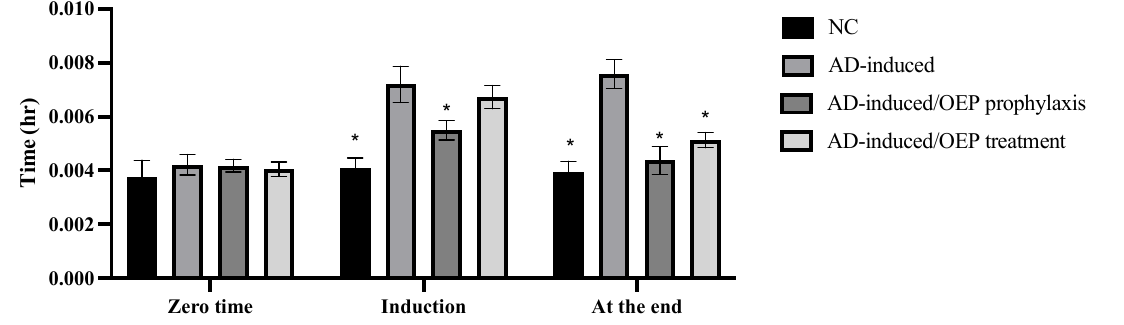
Figure 10. Prophylactic and therapeutic effects of OEP extract on time spent in the T-maze by different animals. Data represent the mean ±SD ( n = 8). Significant difference was analyzed by one-way ANOVA, followed by a post hoc Dunnett’s test, where * p < 0.001, compared with the AD-induced group. NC: negative control group; AD: Alzheimer’s disease (AD)–induced rats received AlCl 3 orally at a dose of 17 mg/kg body weight daily for 21 days.